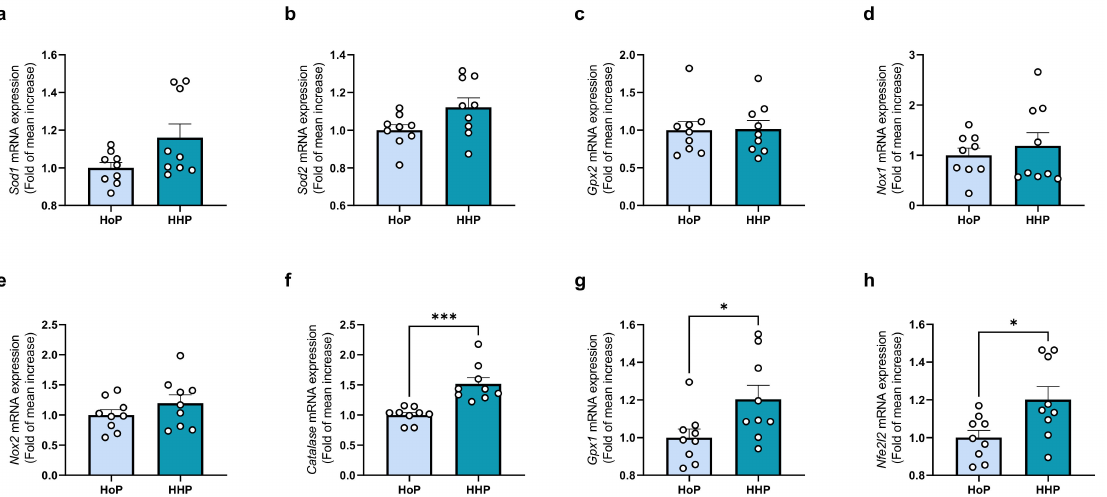
Figure 2. Antioxidant systems gene expression levels in ileum of mice following a 7 days gavage with HoP- or HHP-DM. ( a ) Sod1 (Superoxide dismutase 1), ( b ) Sod2 (Superoxide Dismutase 2), ( c ) Gpx2 (Glutathion peroxidase 2), ( d ) Nox1 (NADPH Oxidase 1), ( e ) Nox2 (NADPH Oxidase 2), ( f ) Catalase (Catalase), ( g ) Gpx1 (Glutathion peroxidase 1), ( h ) Nfe2l2 (Nuclear Factor Erythroid-2 like 2). n = 9 in each group, * p < 0.05, *** p < 0.001.